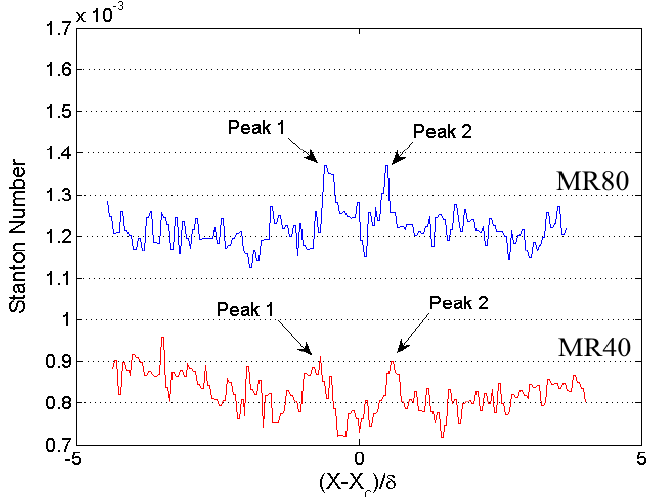
Figure 15. The plot of Stanton number along a profile line 0.5 δ downstream of the micro-ramp